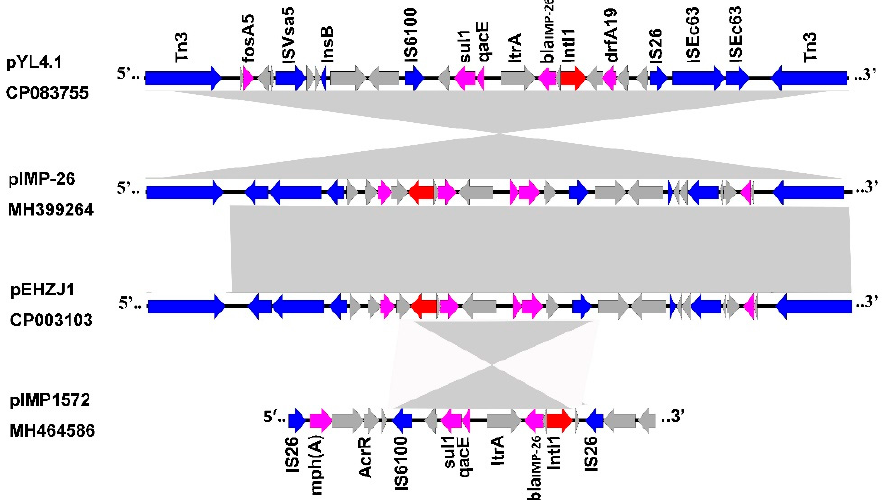
Figure 2. Genetic content of bla IMP-26 . Comparison of the genetic environment of bla IMP-26 between different plasmids. Magenta arrows indicate resistance genes, and blue arrows indicate insertion sequences. Shading regions denote homologous regions (>95% nucleotide identity).